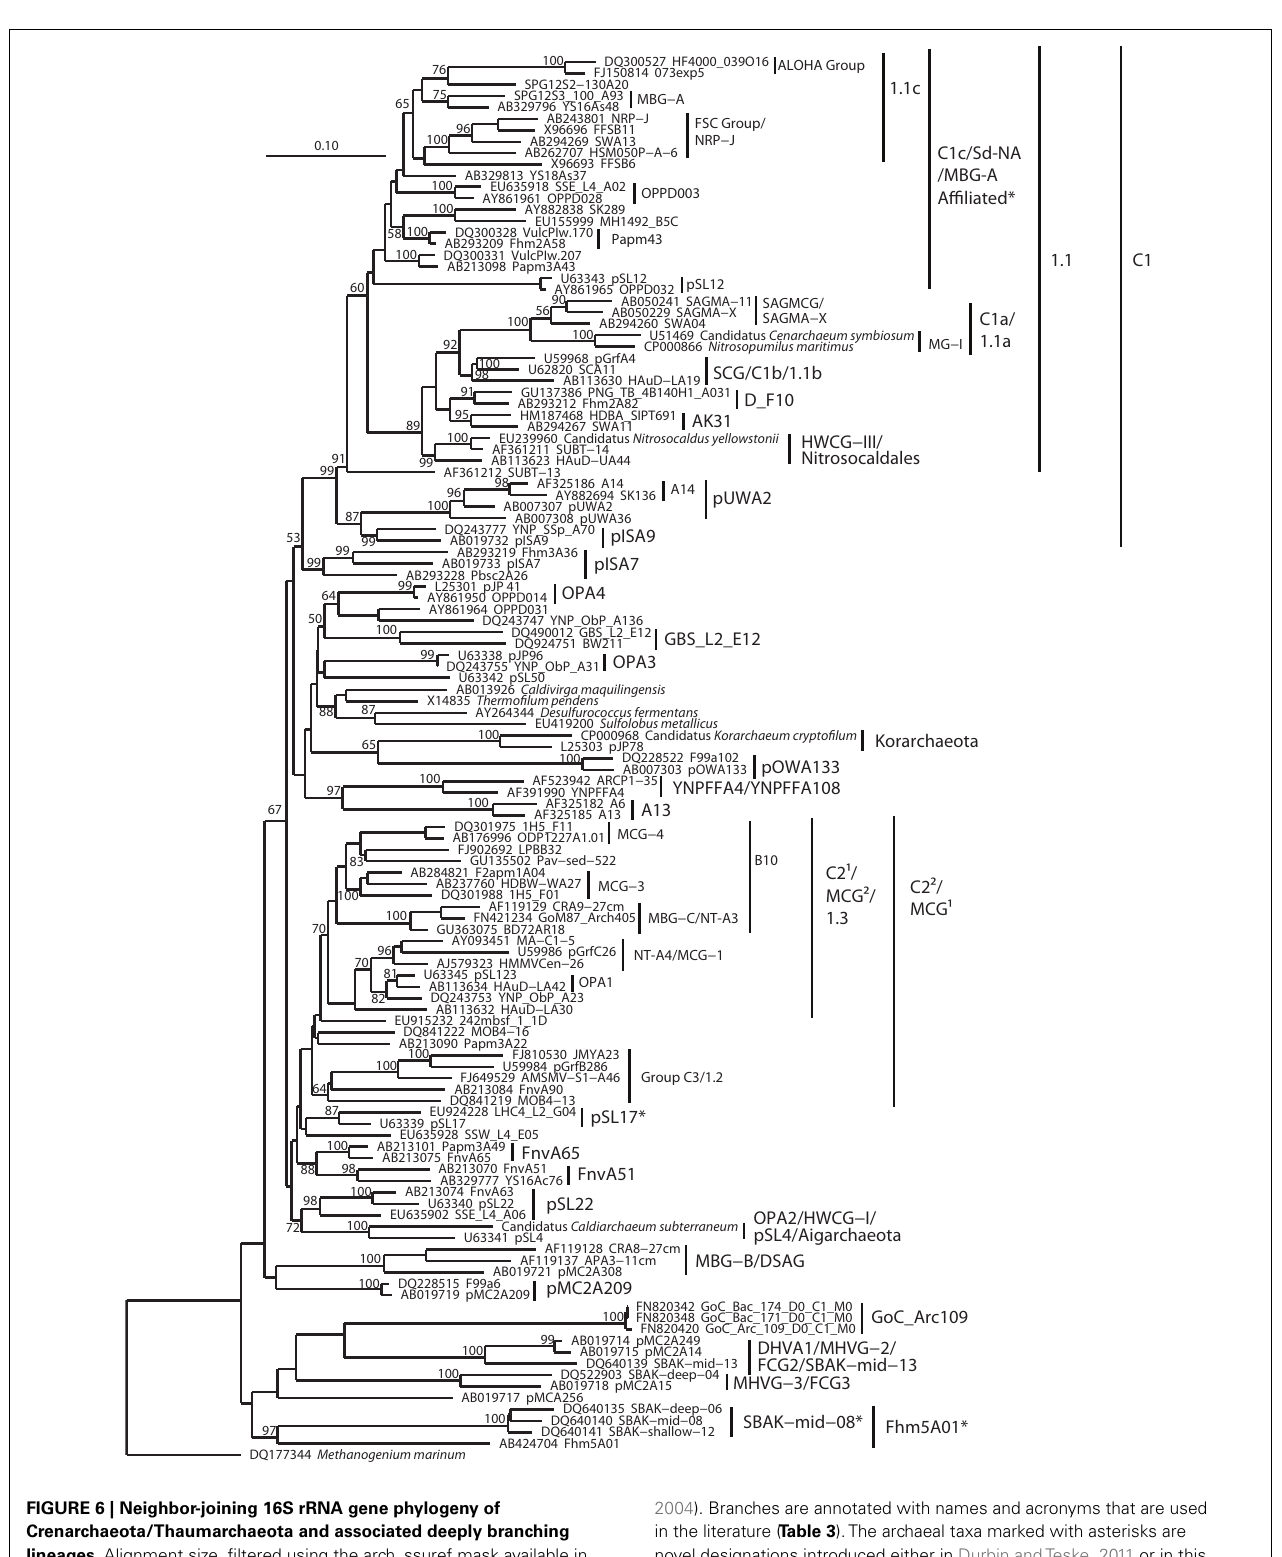
FIGURE 6 | Neighbor-joining 16S rRNA gene phylogeny of Crenarchaeota/Thaumarchaeota and associated deeply branching lineages. Alignment size, filtered using the arch_ssuref mask available in ARB, is 1177 sites. Bootstrap support was estimated using 500 maximum likelihood bootstrap replications inTreeFinder (Jobb et al.,